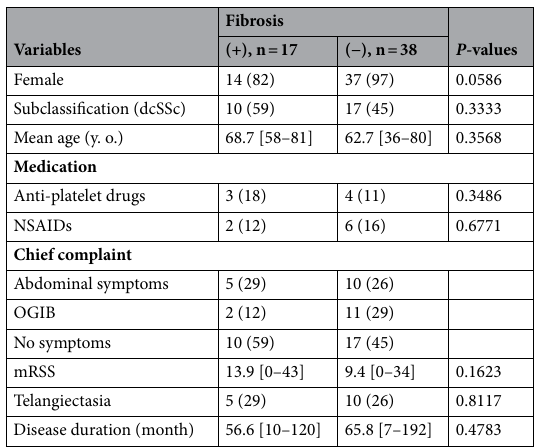
Table 4. Patient characteristics according to the presence of fibrosis in the gastrointestinal tract. Data are shown as frequencies (percentages) or means, as appropriate. SSc: systemic sclerosis, dcSSc: diffuse cutaneous SSc, NSAIDs: non-steroidal anti-inflammatory drug, OGIB: obscure gastrointestinal bleeding, mRSS: modified Rodnan’s total skin thickness score.